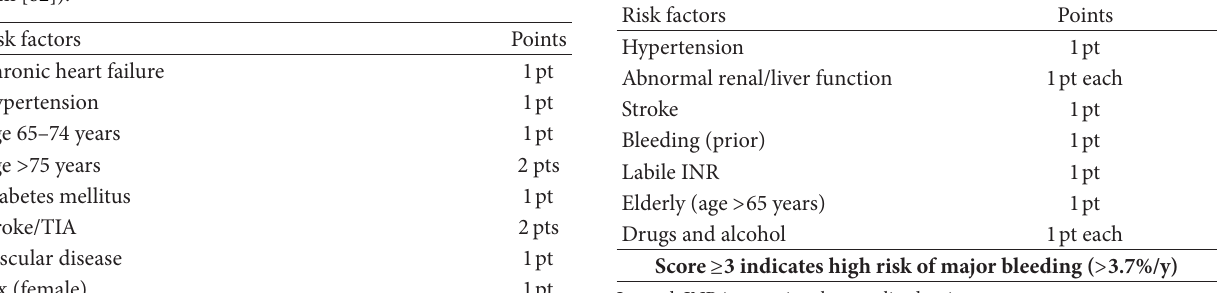
Table 5: The HAS-BLED score: pointing